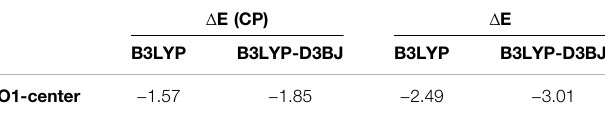
TABLE 3 | CP corrections for the most favored O1-center adsorption mode at both B3LYP and B3LYP-D3BJ level of theory. Energies are given in